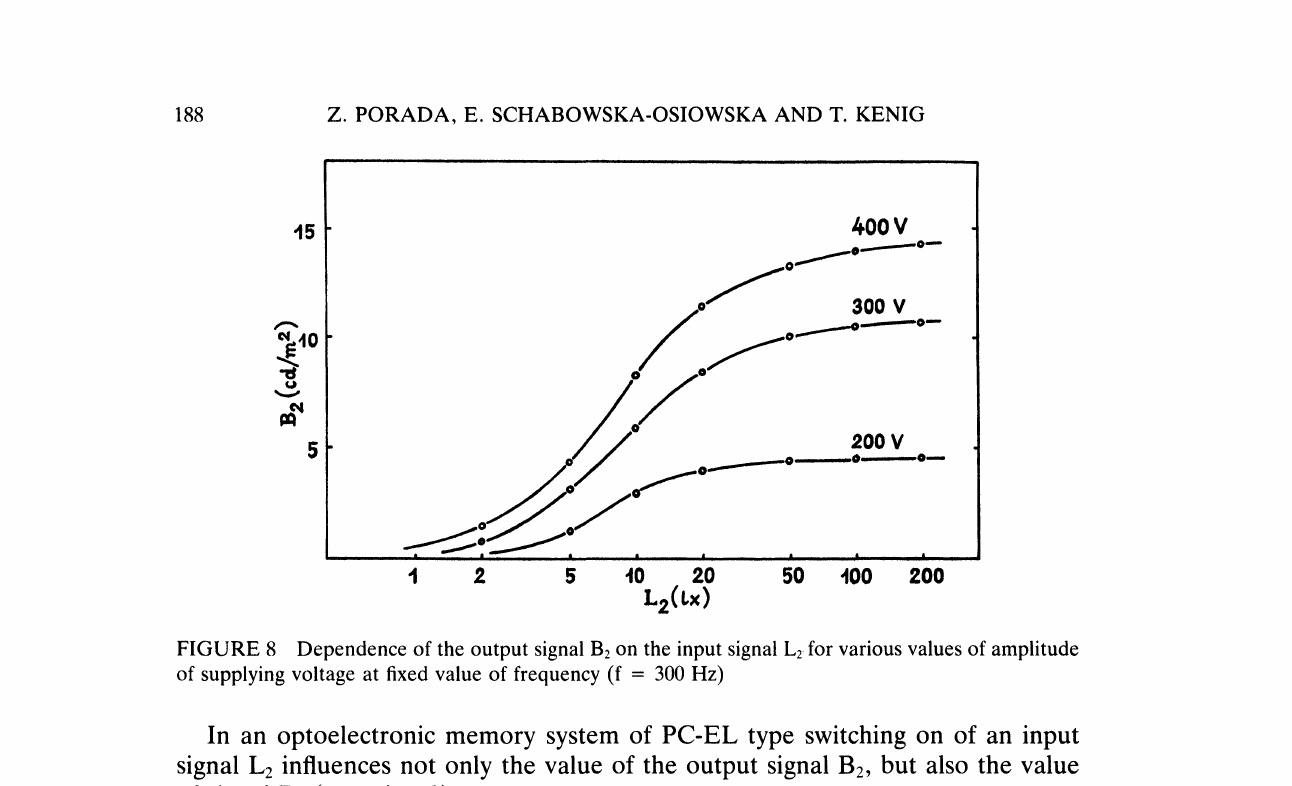
FIGURE 8 Dependence of the output signal B2 on the input signal L2, for various values of amplitude of supplying voltage at fixed value of frequency (f 300 Hz)